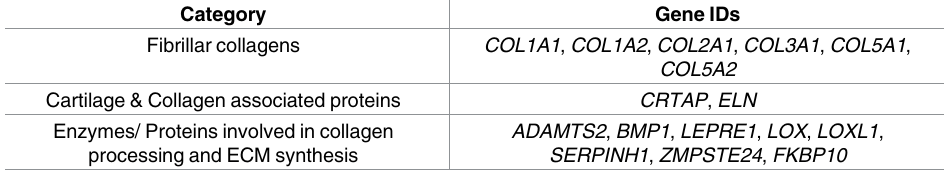
Table 5. Candidate genes selected for